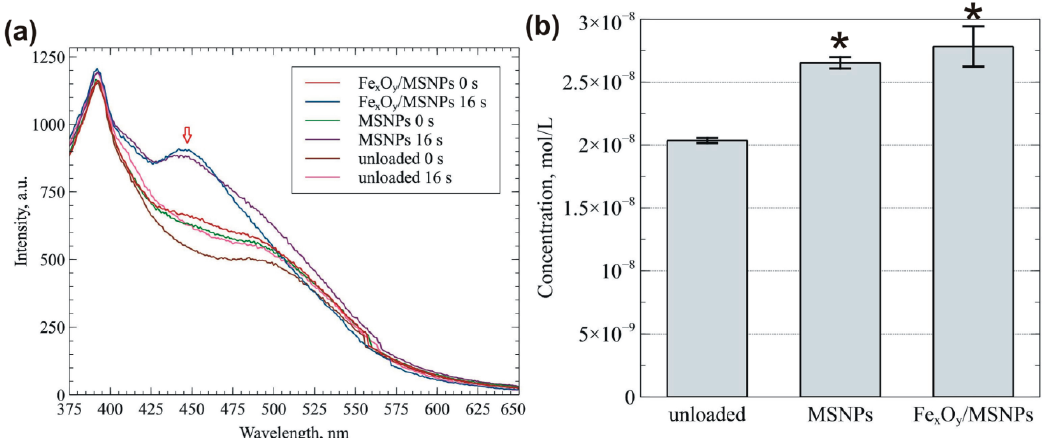
Figure 6. Plasma-induced OH production by biomaterials: ( a ) emission intensities of tested scaffolds (an arrow indicates emission peak of umbelliferone); ( b ) umbelliferone concentrations in HBSS solutions after 16 s GAD plasma treatment (* significantly different results compared to the control biomaterial (unloaded), according to One-way Anova followed by Tukey’s test, p <